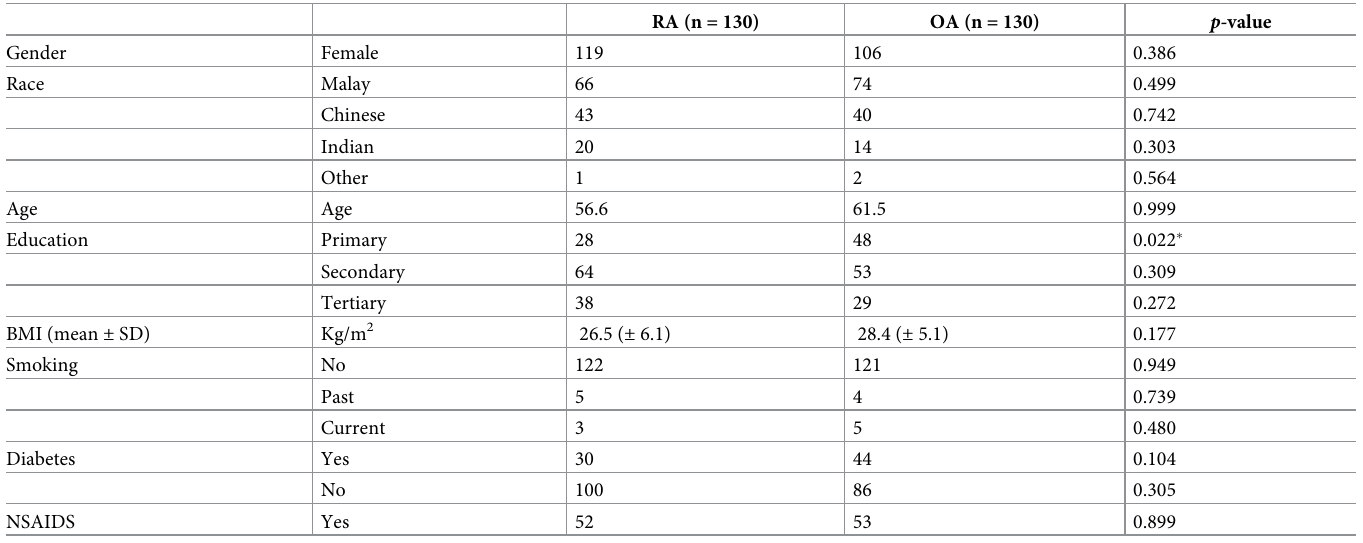
Table 1. Demographic data for study